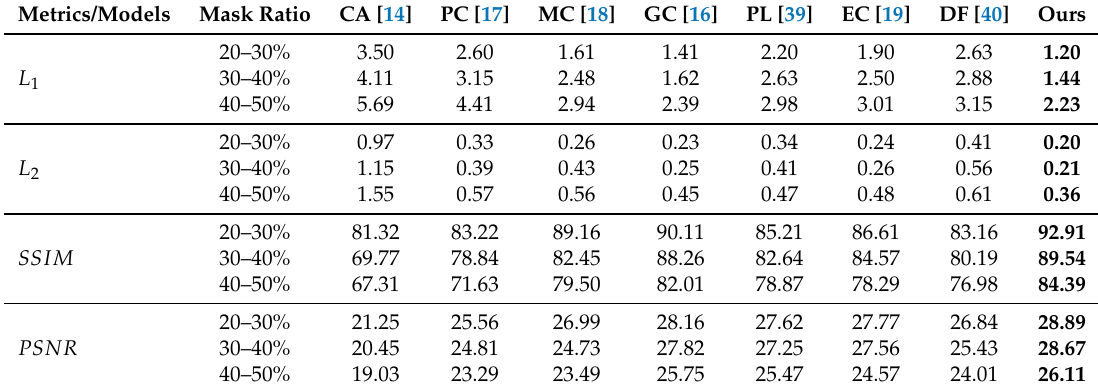
Table 1. Quantitative comparison on Places365 [21] dataset.